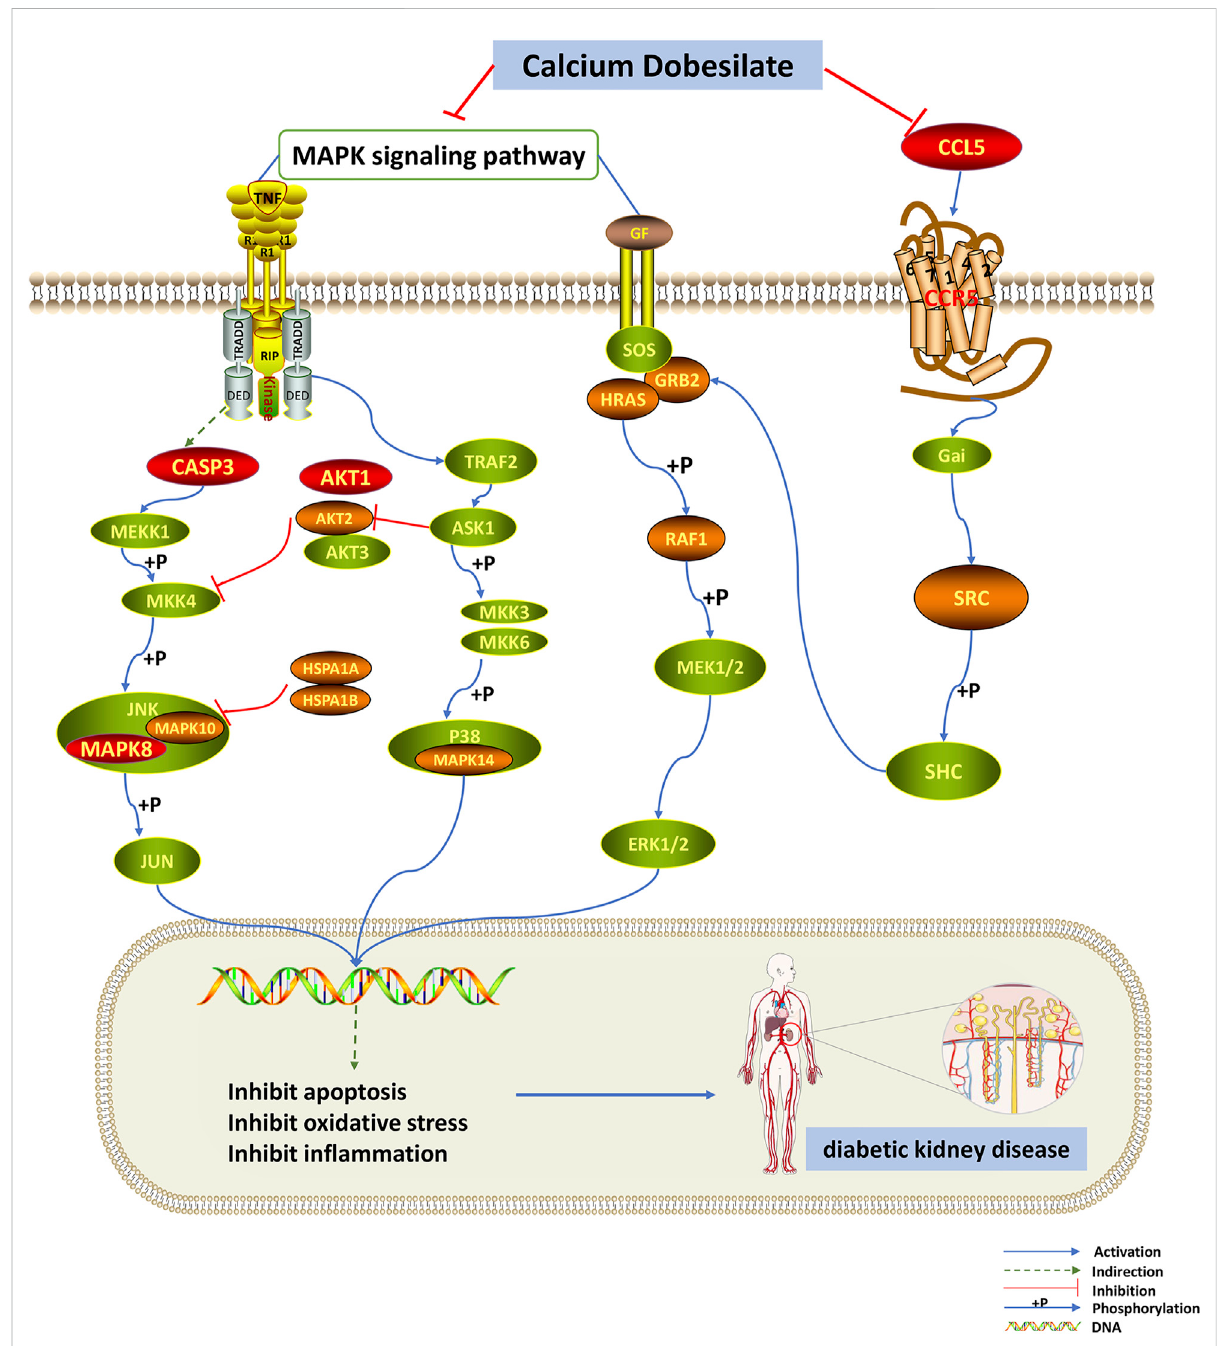
FIGURE 7 MAPK and chemokine signaling pathways are in fl uenced by dapagli fl ozin. The red nodes represent thekey targets, theorange nodes represent common targets of CaD and DKD targets, and the green nodes represent the other targets of these two pathways. CaD affects the phosphorylation of MAPK14 in the p38/MAPK pathway. In the JNK pathway, CaD affects the phosphorylation of MAPK8 and MAPK10 and it also indirectly affects the activation of CASP3. As for the classical MAPK signaling pathway, CaD affects the activation of GRB2, HRAS, RAF1, and the phosphorylation of MEKandERK.The chemokine signaling pathway iscloselyrelated totheclassicalMAPK signaling pathway.CaD inhibitstheexpression ofCCL5.CaD inhibits apoptosis, oxidative stress, and in fl ammation by inhibiting the MAPK signaling pathway and the chemokine signaling pathway, thereby exerting a therapeutic effect on